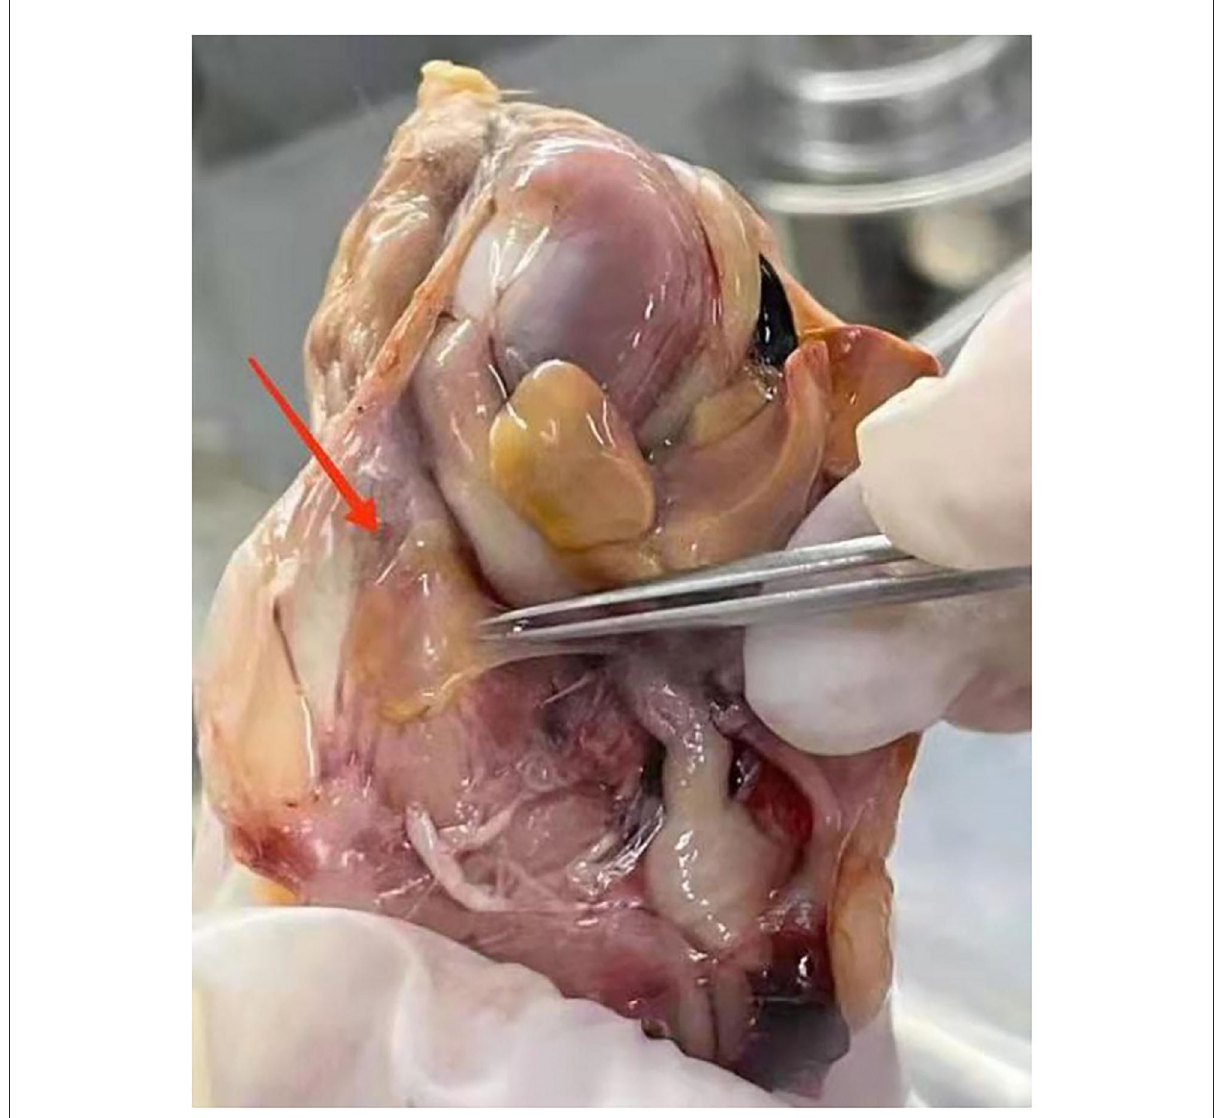
FIGURE1 The symptoms of air sac in Mycoplasma gallisepticum ( M. gallisepticum )-infected